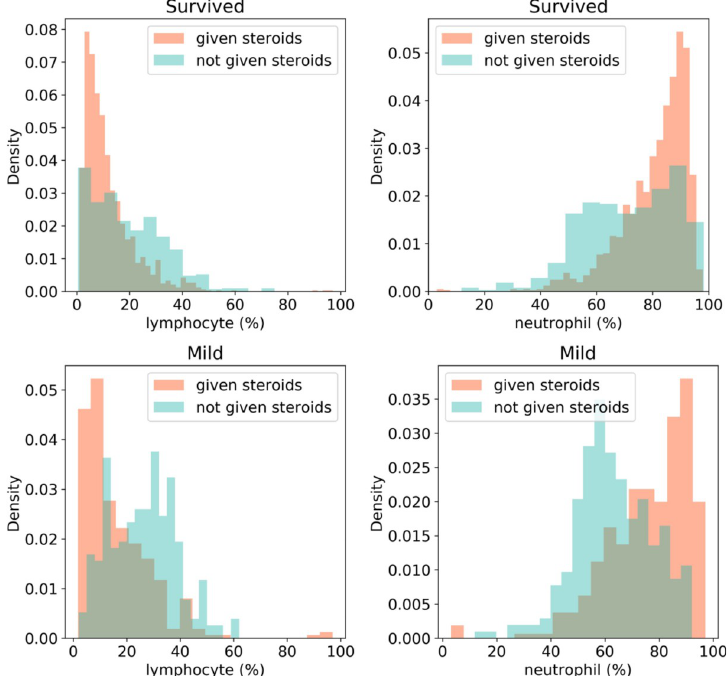
Fig 5. Distribution plots for lymphocyte (%) and neutrophil (%) in steroid administered and non-administered patients having mild and severe